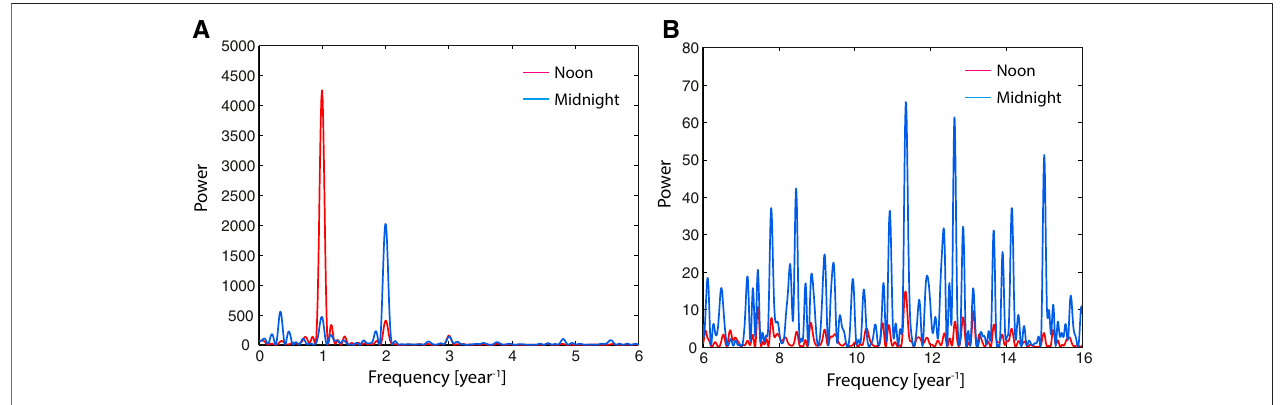
FIGURE1|(A) Powerspectraformedfromthe4-hbandofmeasurementscenteredonnoon(red)andmidnight(blue)forthefrequencyband0 – 6 years − 1 .Wesee thatthebiggestdaytimeoscillationisat1 year − 1 ;thebiggestnighttimeoscillationisat2 years − 1 . (B) Powerspectraformedfromthe4-hbandofmeasurementscentered on noon (red) and on midnight (blue) for the frequency band 6 – 16 years − 1 . We see that there are strong oscillations in the expected rotational frequency band 10 – 14 years − 1 (noteespeciallythepeaksat11.35and12.64 years − 1 )inthenighttimedata,butcomparativelysmalloscillationsinthedaytimedata(Cf Tables3 , 4 ).